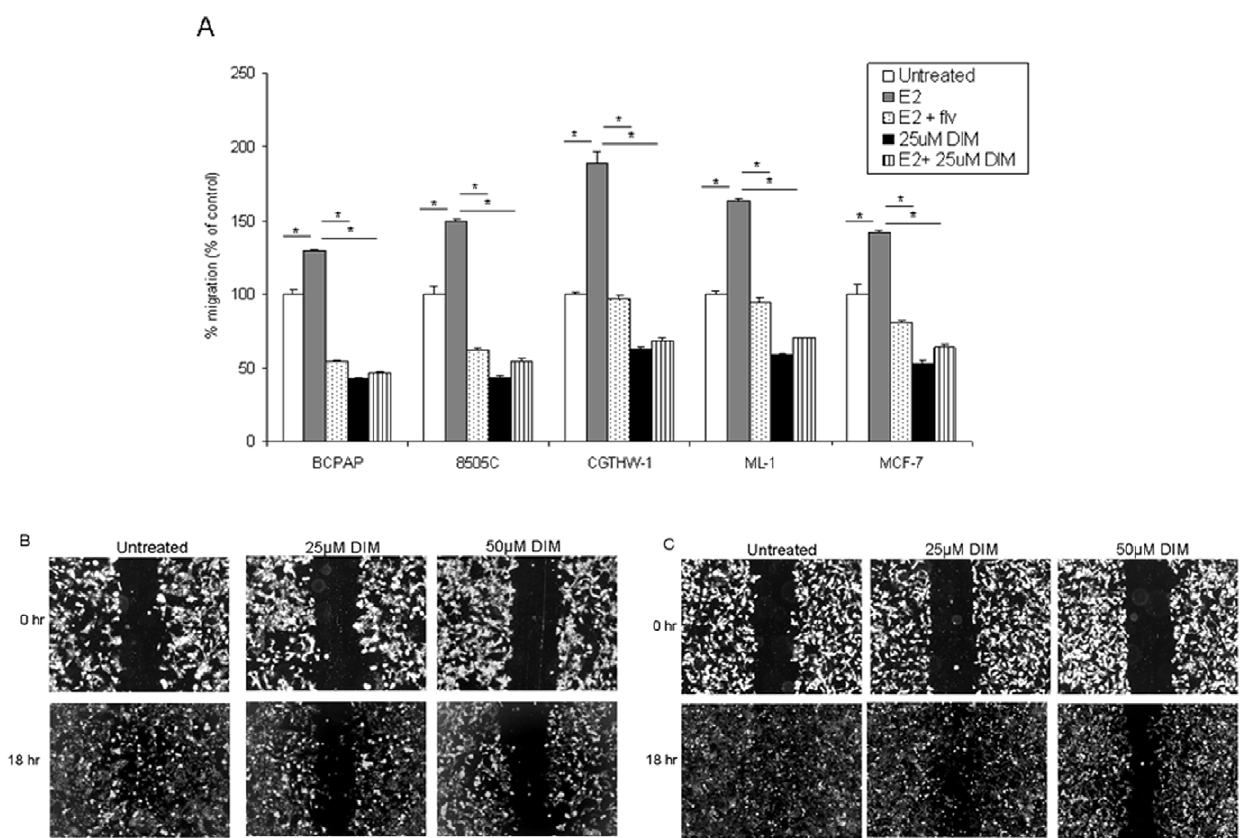
Figure 2. DIM reduces migration of thyroid cells. (A) 2.5 6 10 4 cells were resuspended in 500 m l of RPMI with 1% FBS 6 10 2 8 M E 2 6 10 2 6 M fulvestrant 6 25 m M DIM and seeded in the upper chamber of BD Biocoat Control Inserts (8- m m pore membrane filters). 750 m l of RPMI containing